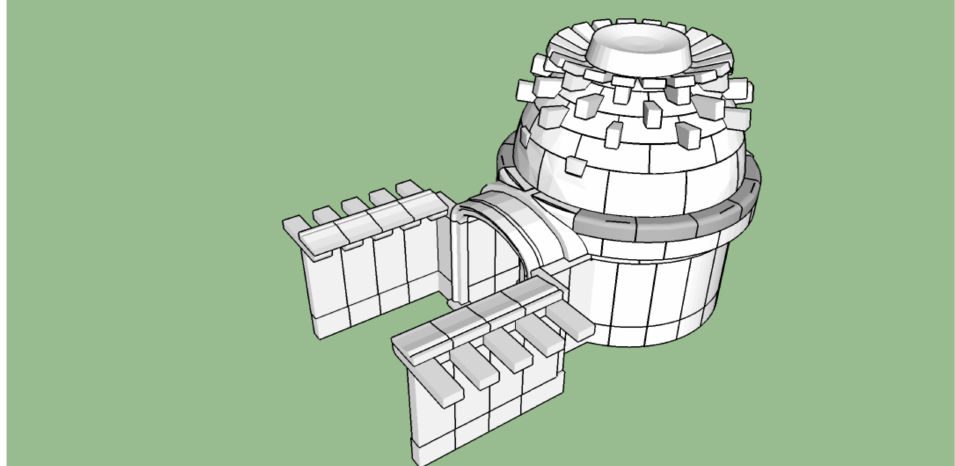
Figure 27. Visualization of the model in its current